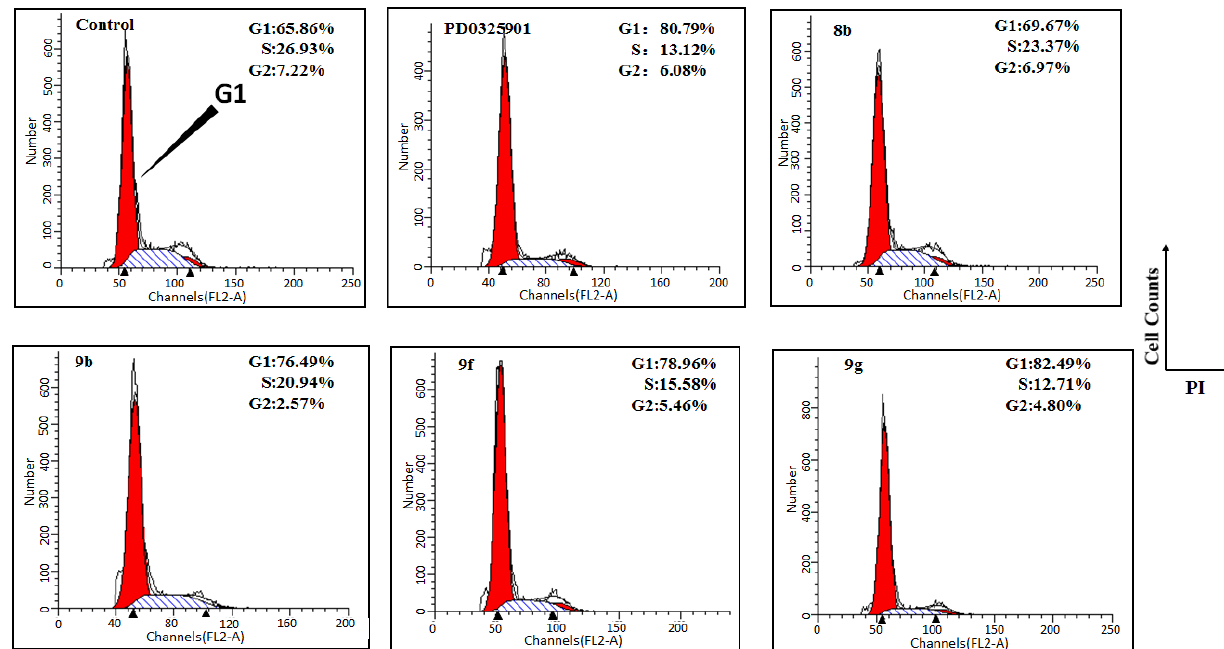
Figure 4. RGD-MEKI induced cell cycle arrest in melanoma A375